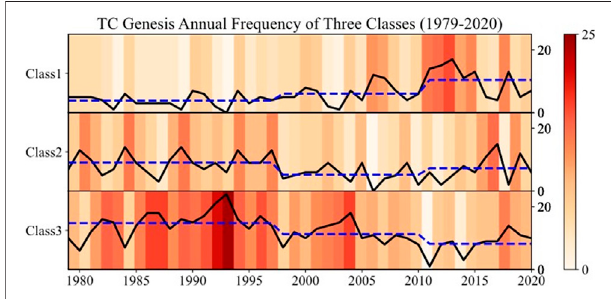
colour refers to the number of TC cases in the three classes each year. The x- axis refers to the year, the left y-axis refers to the class, and the right y-axis is the TC genesis count. The solid black lines refer to the time series of the TC genesis count in each class based on the IBTrACs dataset, and the dashed blue lines refer to the average value of TC genesis cases in P1, P2, and